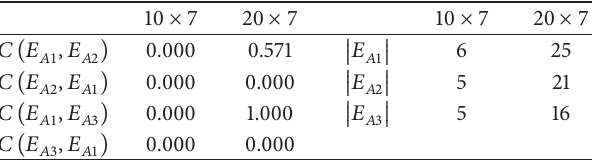
Table 6: Results of the 𝐶